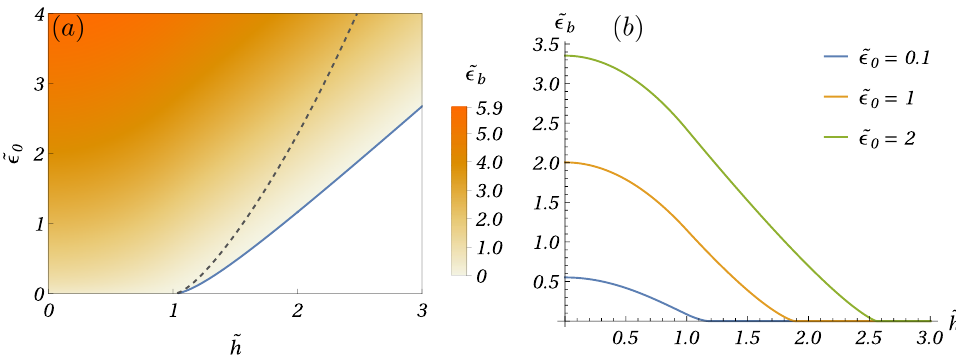
Figure 1: Binding energy of a 2D-fermion dimer with zero center-of-mass momentum ( P = 0 ) formed in the presence of 2D-type spin-orbit coupling and Zeeman splitting. Orange color in panel (a) indicates the parameter region where a bound state exists. The analytical result (51) for its boundary is indicated by the solid blue curve, and the dashed black curve indicates the dividing line between regions where the two differ- ,˜ h ) given in Eq. (49) apply. Here ˜ ε ( ˜ E ≡ ε / ( m λ 2 ) and ˜ h ≡ h / ( m λ 2 ) ent forms of F 0 b 0 0 are the s -wave interaction strength and the Zeeman energy, respectively, measured in units of the spin-orbit-coupling energy scale m λ 2 . The dimensionless binding en- ≡ ε / ( m λ 2 ) is represented by the color scale in panel (a) and plotted as a ergy ˜ ε b b function of ˜ h for selected values of ˜ ε in panel 0